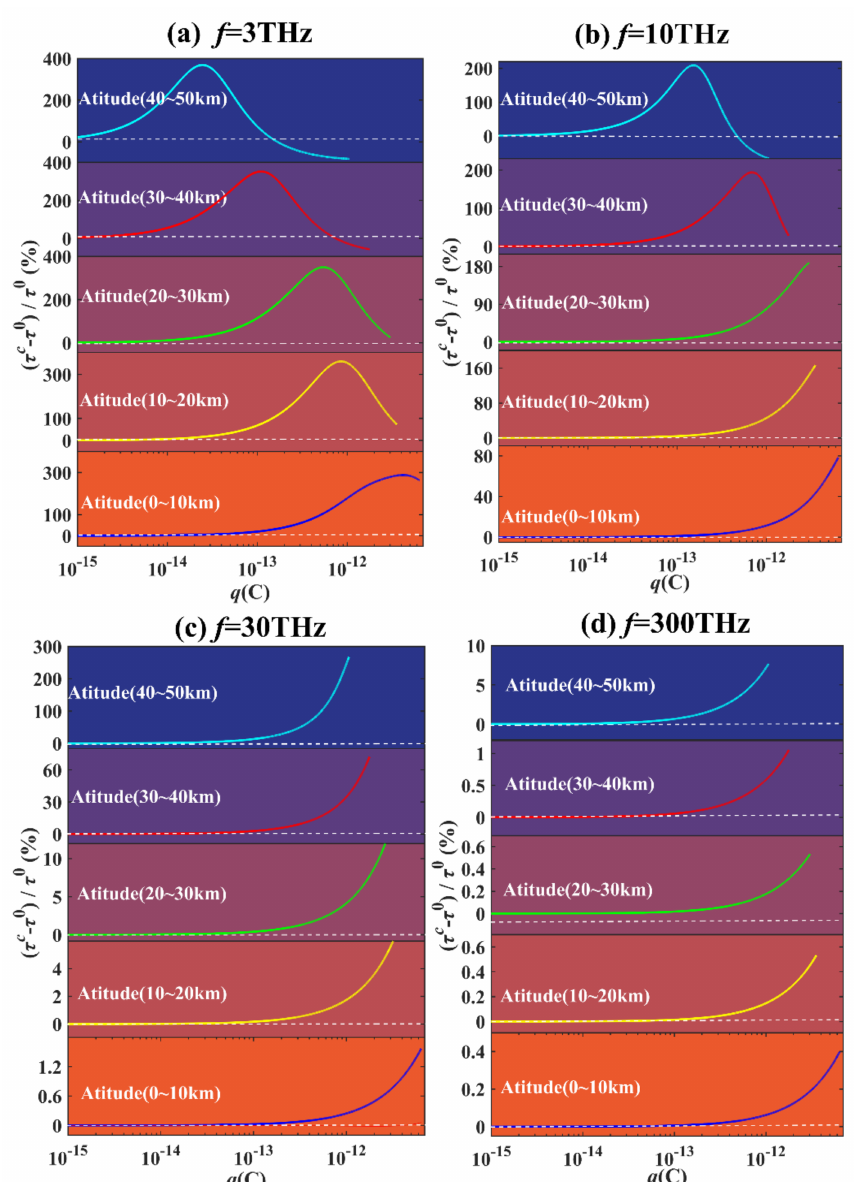
Figure 8. Difference between the DOD of charged Martian dust particles and uncharged dust particles for frequencies ( a ) f = 3 THz, ( b ) 10 THz, ( c ) 30 THz, and ( d ) 300 THz. Here, q is the total net charge of the charged Martian dust particle. The effective particle radii adopted in the calculation of DOD are ~1.8 µ m at an altitude of 0–10 km, ~1 µ m at an altitude of 10–20 km, ~0.85 µ m at an altitude of 20–30 km, ~0.5 µ m at an altitude of 30–40 km, and ≤ 0.3 µ m at an altitude above 40 km (see ref.